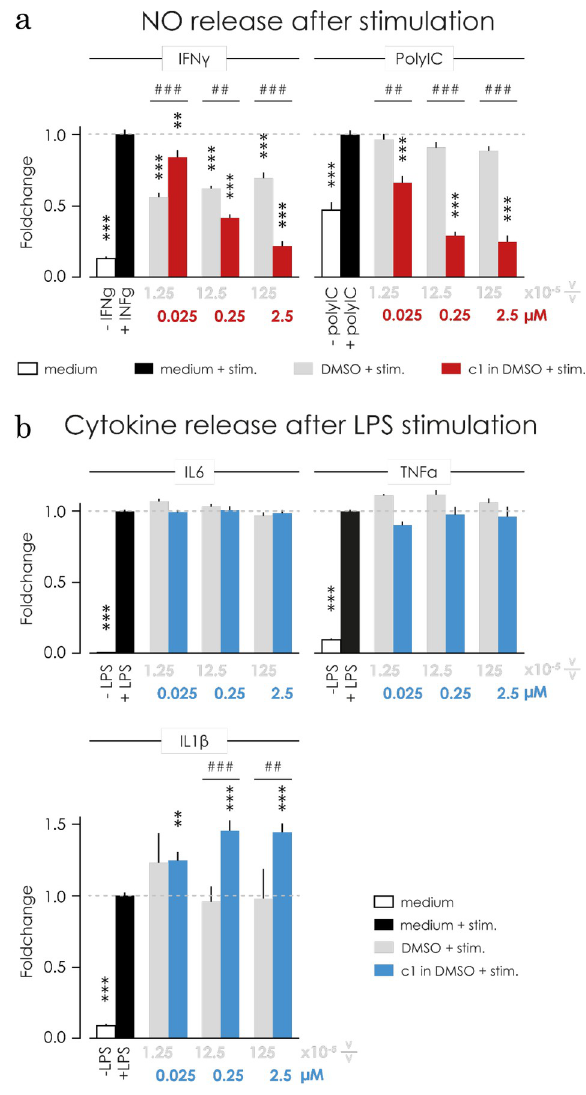
Fig 2. In microglia, C1 reduced NO release triggered by IFN γ and PolyIC, and did not affect LPS induced cytokine release. a) Stimulation of microglia with IFN γ (100 ng/mL) for 48 hours (left, in black) and PolyIC (100 μ g/ mL) for 24 hours (right, in black) caused a significant increase in the production of NO (p < 0.0001) in comparison with unstimulated control (white bar). Treatment with C1 caused a dose-dependent decrease of NO release in primary cultured microglia upon stimulation with IFN γ (left, in red) and PolyIC (right, in red). Incubation with DMSO (in grey) had no effect on the NO release under PolyIC stimulated condition, however, DMSO decreased the NO level in IFN γ -stimulated microglia (p < 0.0001) but not dose dependently. b) Pre-treating microglia for 1 hour with C1 followed by an 48 hour stimulation with LPS (1 μ g/mL, black bar) increased the concentration of the pro-inflammatory cytokines IL6, TNF α and IL1 β compared to the negative control (plain medium in white). Treatment with C1 (in blue) did not have a significant effect for the LPS-induced IL6 and TNF α release, but increased the release of IL1 β at all tested concentrations (0.025 μ M: p = 0.0037, 0.25 μ M: p < 0.0001, 2.5 μ M: p < 0.0001). The respective DMSO controls (grey bar) did not significantly affect the IL6, TNF α and IL1 β release. ��� p < 0.001 �� p < 0.01 comparing to stimulated control; ### p < 0.001 ## p < 0.01 compared to DMSO (1way ANOVA followed by Bonferroni’s post-hoc